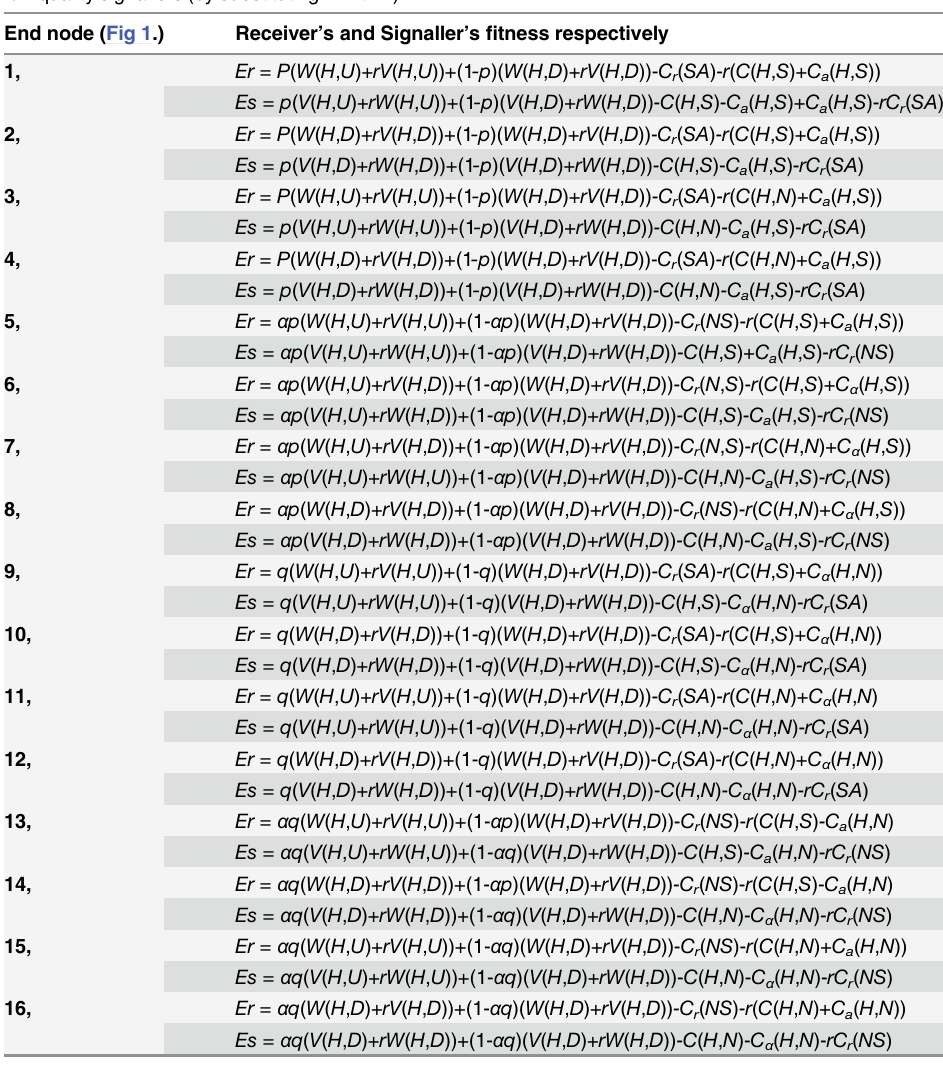
Table 2. The fitness values corresponding to the end nodes in Fig 1, where Es and Er denote the inclu- sive fitness of the signaller and the receiver respectively. The fitness of both players is a combination of the benefit they receive as a result of the receiver ’ s decision and the costs they have to pay depending on their own decisions (e.g. signal or not to signal, search or not to search, etc.)The same table can be drawn for low quality signallers (by substituting H with